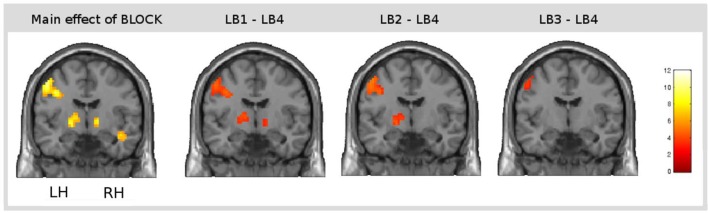
Result of the main effect of the 2 × 4 ANOVA with the factors CONDITION and BLOCK and post-hoc t-tests to test simple main effects rendered on a coronal slice. Bilateral basal ganglia showed learning-related changes over time. The main effect of the factor BLOCK (learning block 1–4) at the position y = −7, and, from left to right, contrasts between the first (LB1), the second (LB2), and the third learning block (LB3) with the last learning block (LB4) illustrate the direction of changes over time. The colorbar represents z-values.